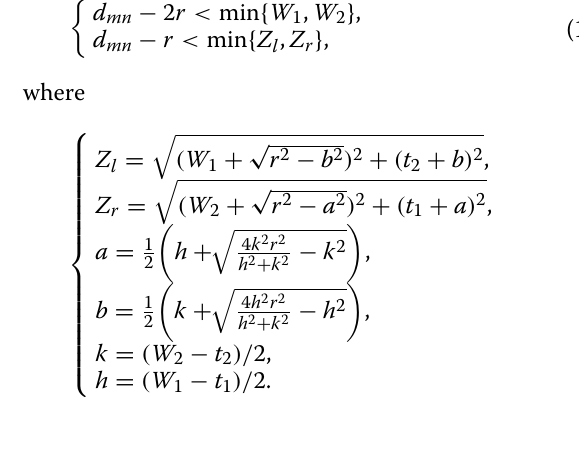
Fig. 6 Rigid object covered with a soft part. a Hand and b object model